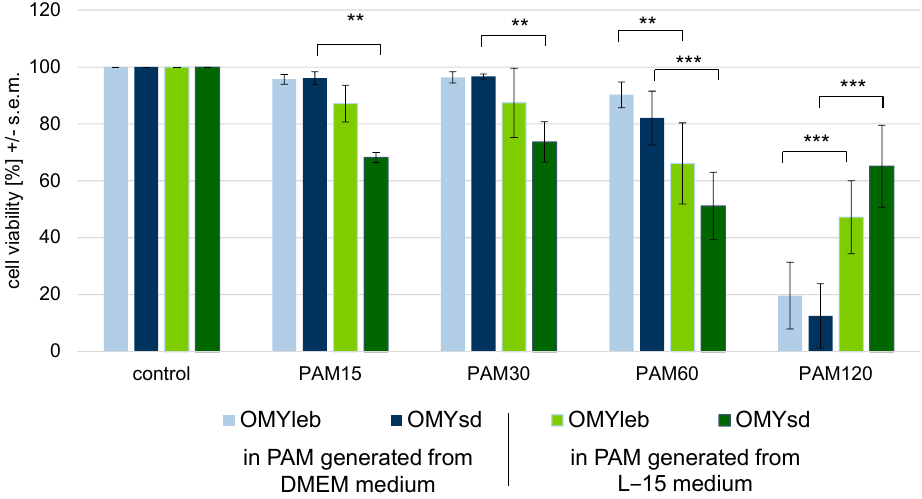
Figure 5. Cell viability after plasma treatment (PAM) when identical numbers of cells were seeded initially. Cells are grown under different medium conditions (DMEM vs. L-15 medium). Note the protective effect of L-15 against the strong PAM120 disturbance ( n = 3).